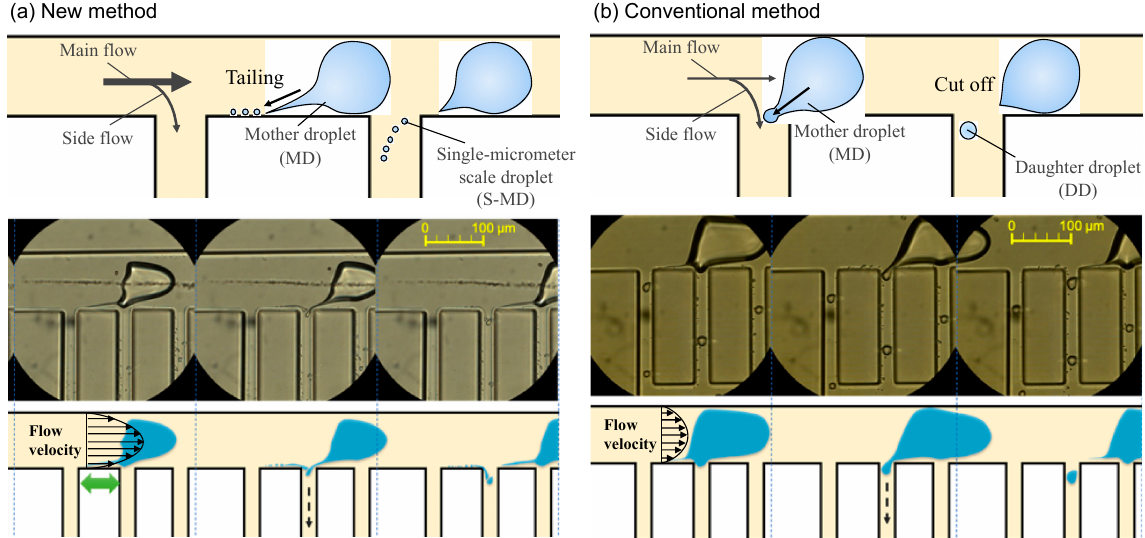
Figure 4. New method for generating single-micrometer droplets (S-MDs). ( a ) New method: MoD tailing occurs at the channel wall, and S-MDs are generated one after another; ( b ) Conventional method: Since the tail of MoD is cut off at the corner of the side channel, a DD is generated, and an S-MD is not generated.